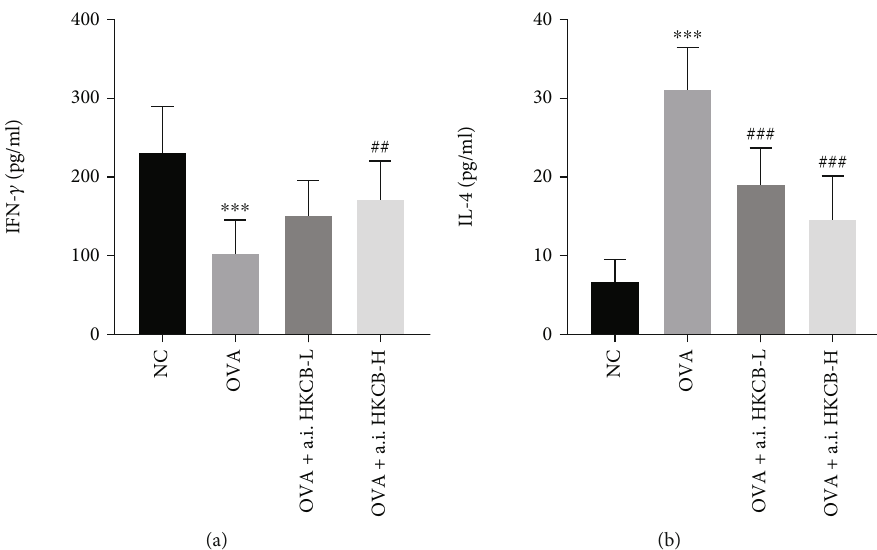
Figure 2: The e ff ect of aerosol inhalation of HKCB on the cytokine concentrations in the BALF of allergic mice. (a) The concentration of IFN- γ . (b) The concentration of IL-4. ∗∗∗ P < 0 : 001 versus the NC group; ## P < 0 : 01 and ### P < 0 : 001 versus the OVA group. a.i.: aerosol inhalation; CB: Clostridium butyricum; HKCB: heat-killed CB; BALF: bronchoalveolar lavage fl